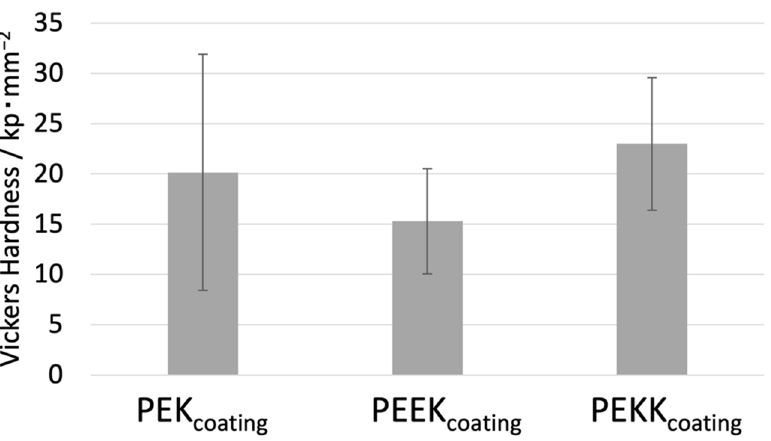
Figure 10. Vickers hardness measurements made in the coatings without PTFE.